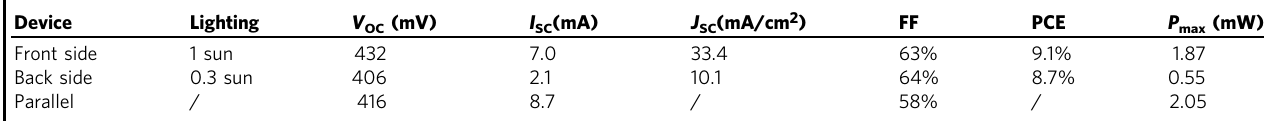
Table 1 The typical photovoltaic parameters of double-sided CZTSSe solar cells in parallel circuit state.